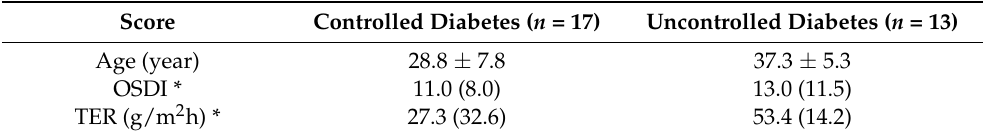
Table 2. The averages (mean ± SD or median (IQR)) for the age, OSDI, and TER scores within controlled and uncontrolled